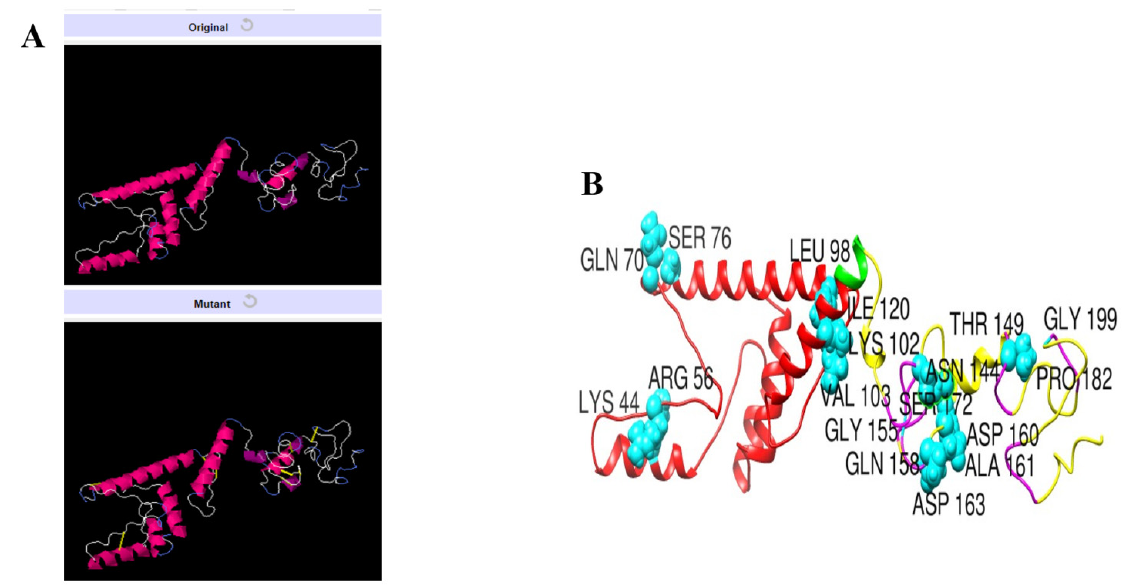
Figure 9. Disulfide engineering of the designed vaccine construct. ( A ) Wild and mutant vaccine. The introduced disulfide bonds are shown by yellow sticks. ( B ) Highlighted mutated residues of the vaccine structure.